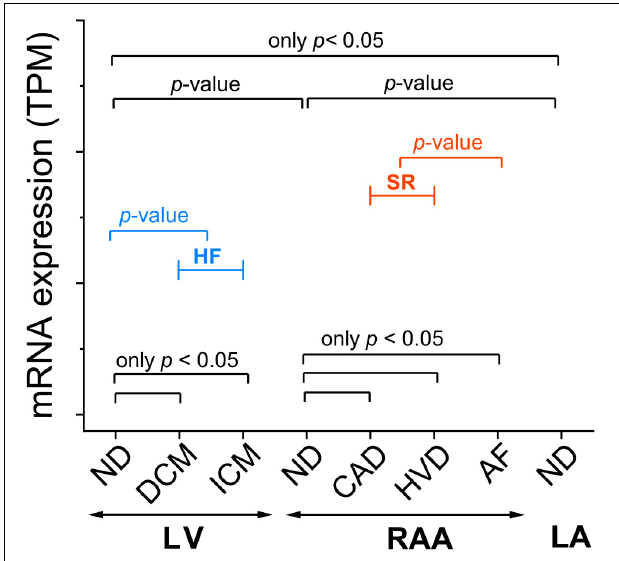
FIGURE 1 | Template figure for presentation of mRNA expression assessed by RNA-seq. Some p -values will be indicated in all graphs ( p -value), whereas others are only indicated when p < 0.05 (only p < 0.05). Sample provenance: left ventricle (LV), right atrial appendage (RAA), left atrium (LA). Patient’s health status: non-diseased (ND); heart failure (HF; blue) summarizing data from dilated cardiomyopathy (DCM) and ischemic cardiomyopathy (ICM); sinus rhythm (SR; red) summarizing data from coronary artery disease (CAD) and heart valve disease (HVD); atrial fibrillation (AF). Statistical significance was assessed by Dunn’s test. For HF and SR, statistical significance was assessed by the Mann–Whitney